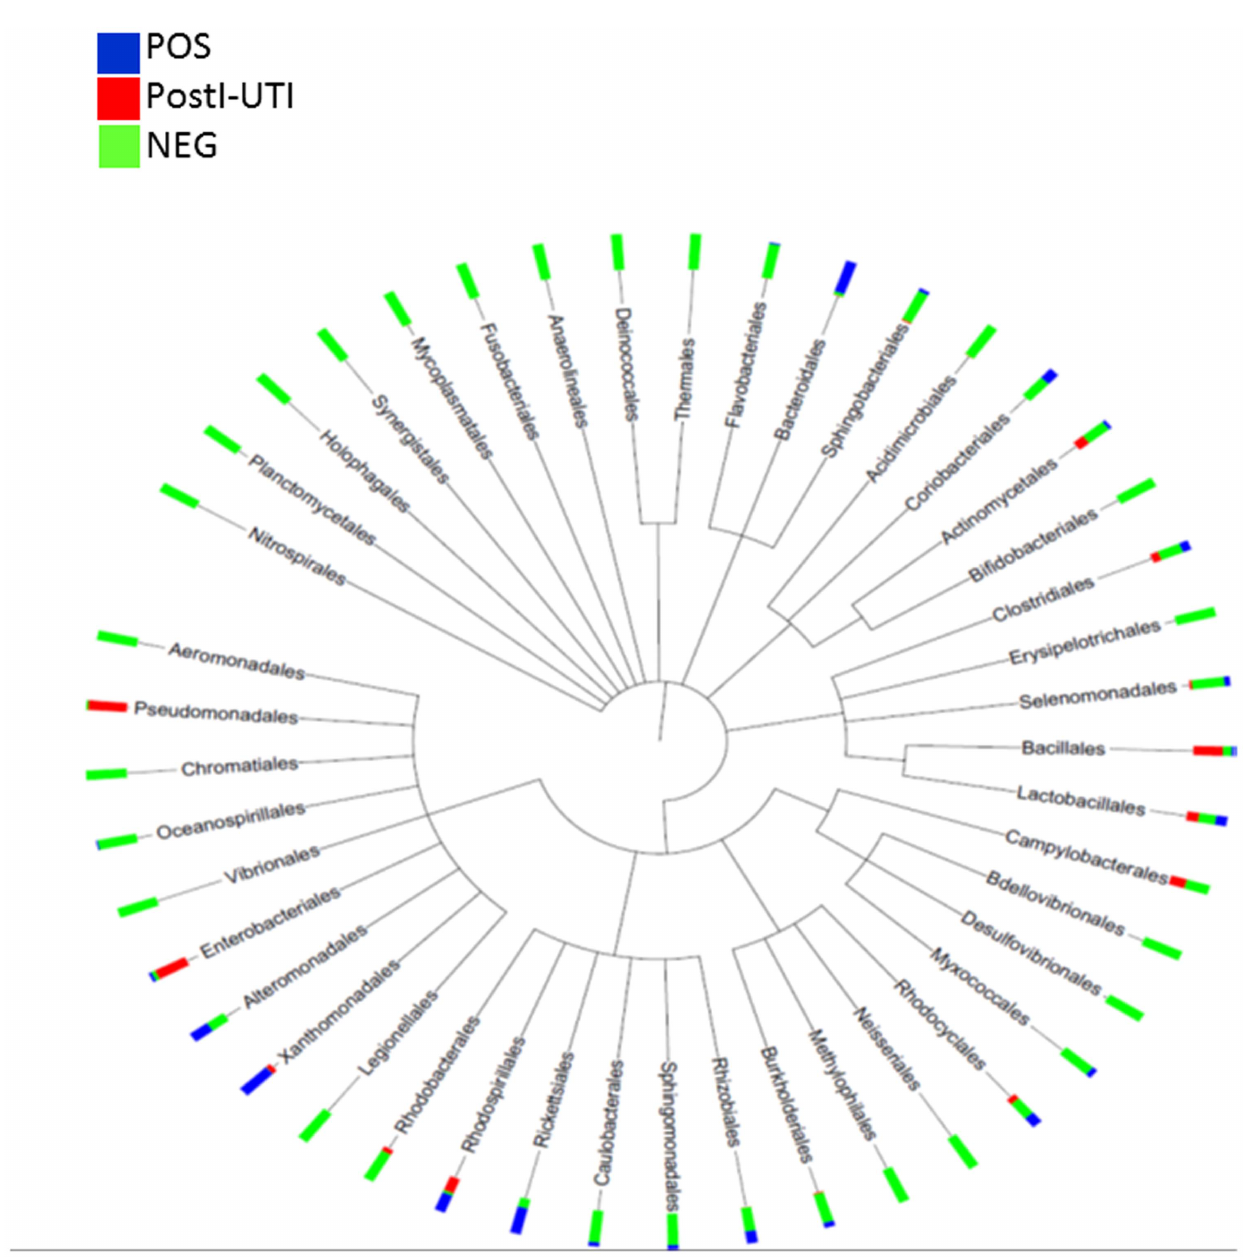
Fig. 1. Bacterial diversity correlates with the susceptibility or resistance to UTI. Phylogenetic tree comparing the bacterial diversity at the Order level within the female urinary microbiome. The bacterial diversity was compared between the three cohorts: POS (Blue), PostI-UTI (Red) and NEG